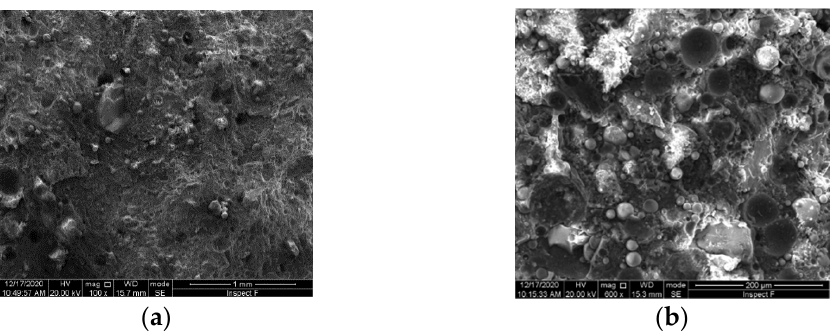
Figure 7. Micro-structure of GHB concrete and plain concrete: ( a ) GHB concrete; ( b ) plain concrete.